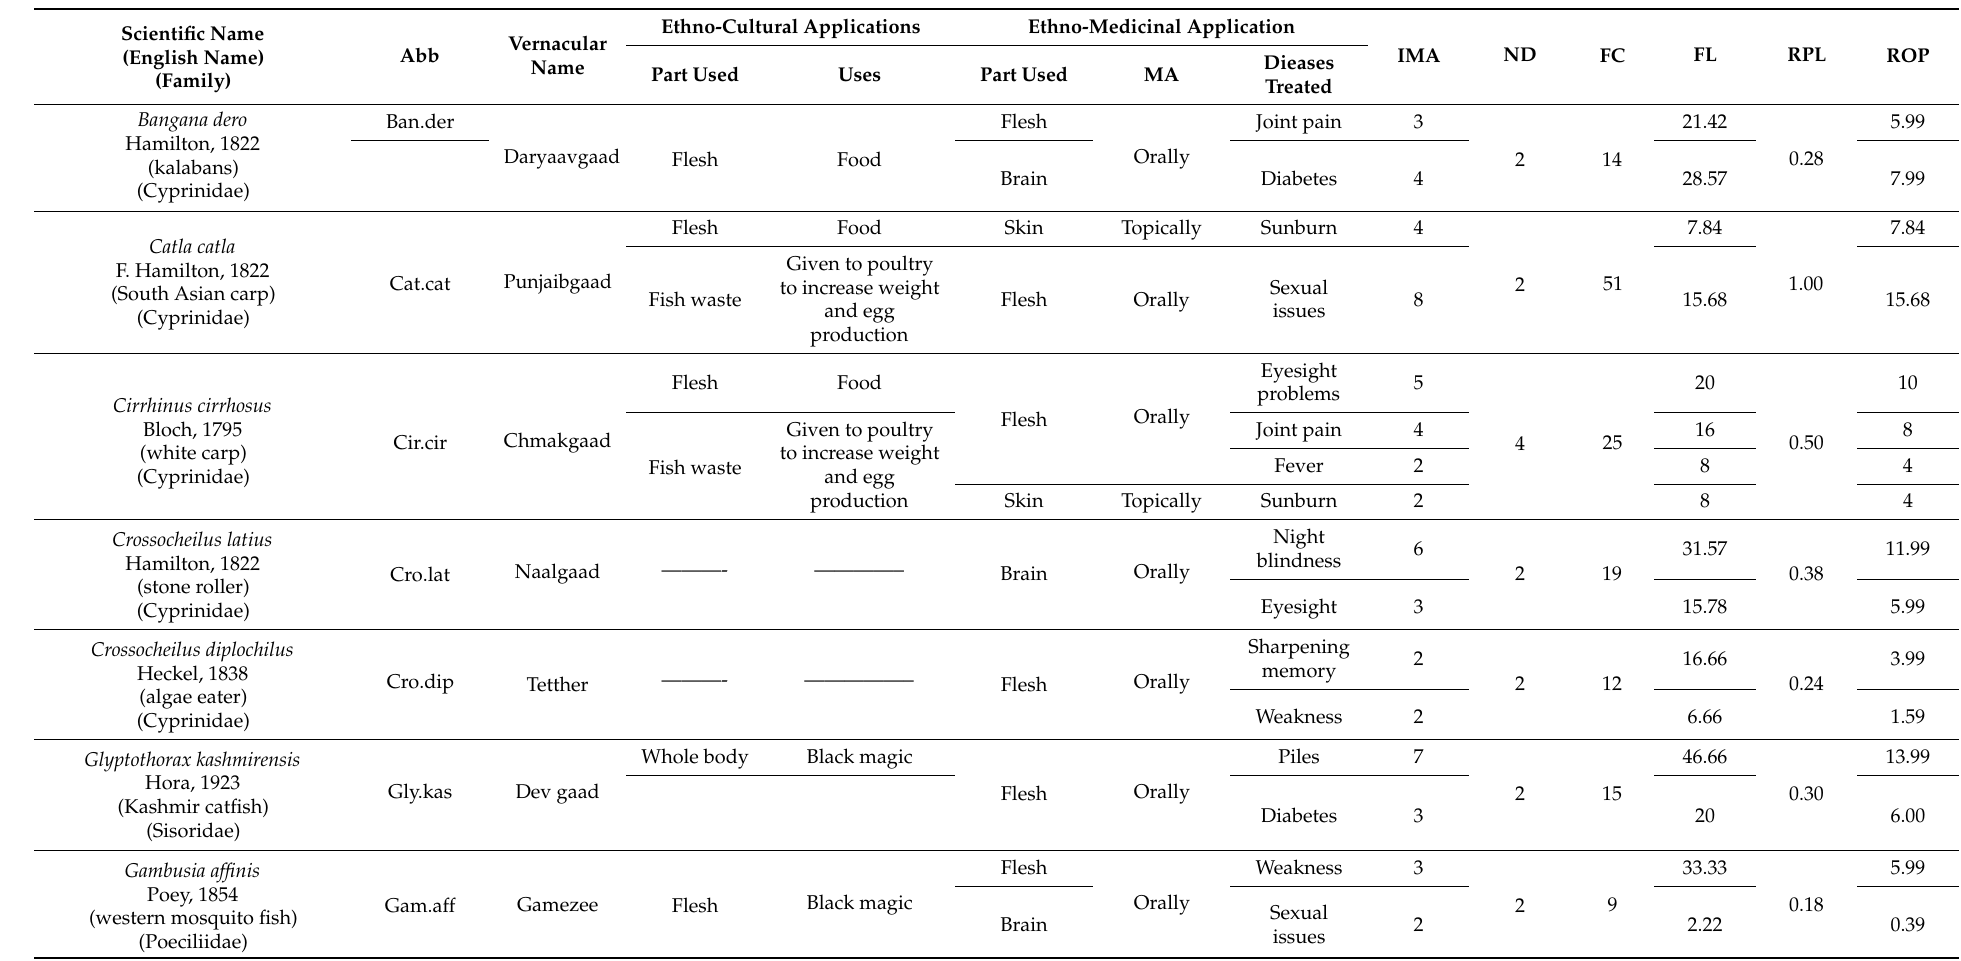
Table 2. Cultural and ethno-medicinal uses of fishes in the Vale of